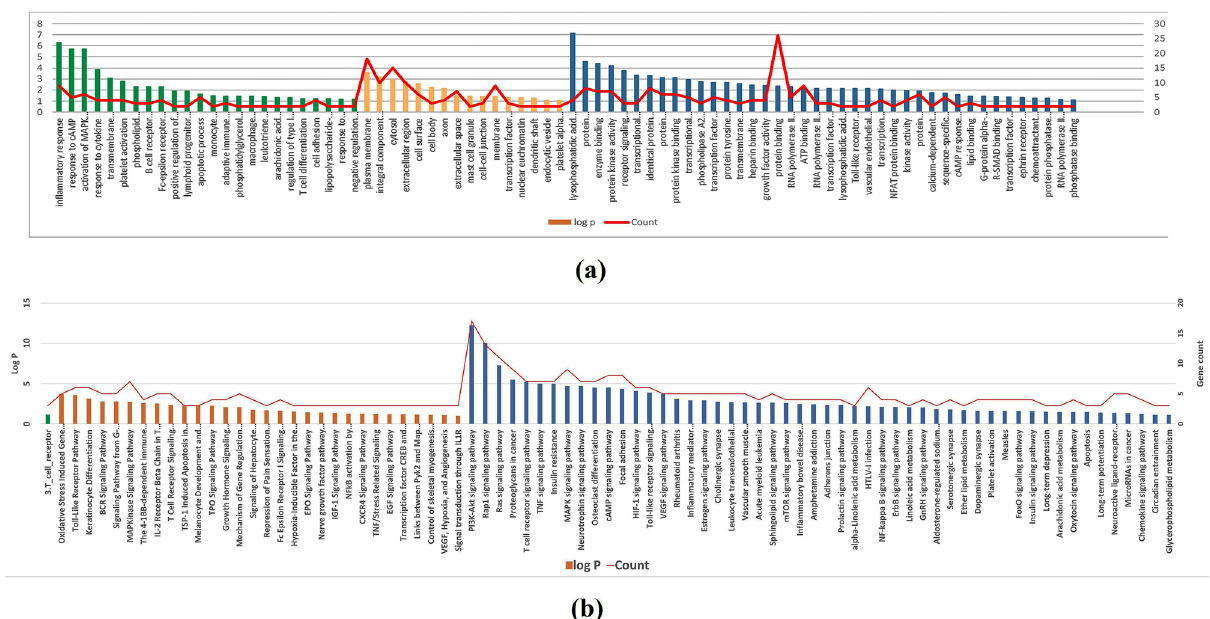
Figure 4. ( a ) Gene Ontology analysis of inflammation targets determined by DAVID database. Biological processes, molecular functions and cellular components are represented by green, orange and blue bars, respectively. ( b ) Major BBID (green), BIOCARTA (orange) and KEGG (blue) pathways clusters generated from DAVID database. The significance of enrichment is indicated by log P-value with bar charts. Red lines represent the number of genes enriched by each term.